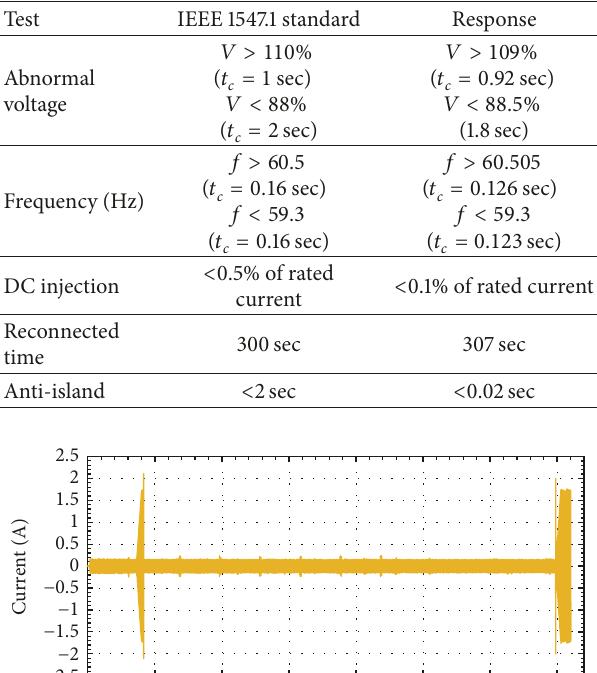
Table 1: IEEE 1547 and microinverter response.